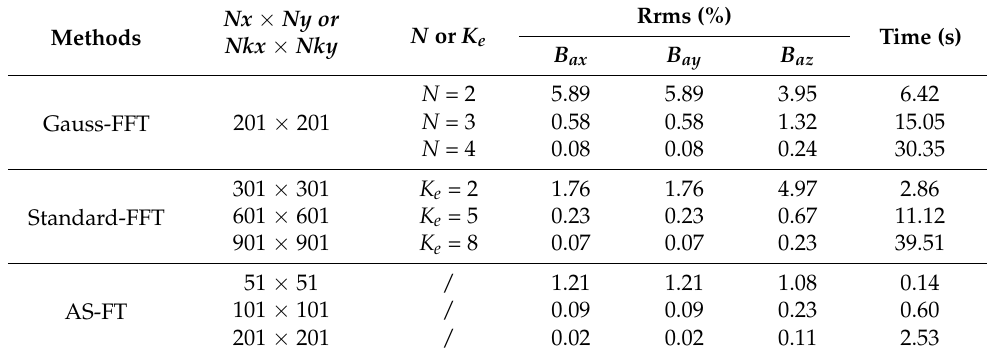
Table 2. Efficiency and accuracy statistics of three Fourier transform algorithms (Nz = 101).